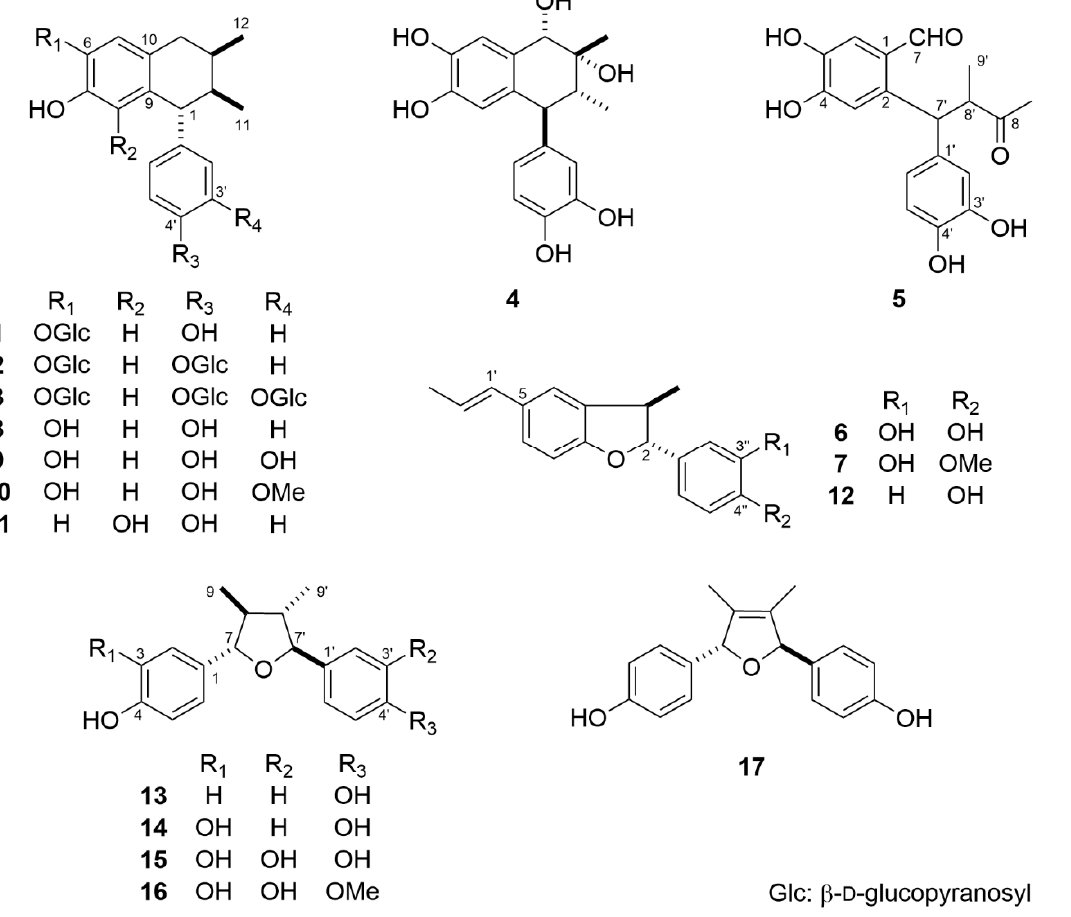
Figure 1. Structures of 1 – 17 .